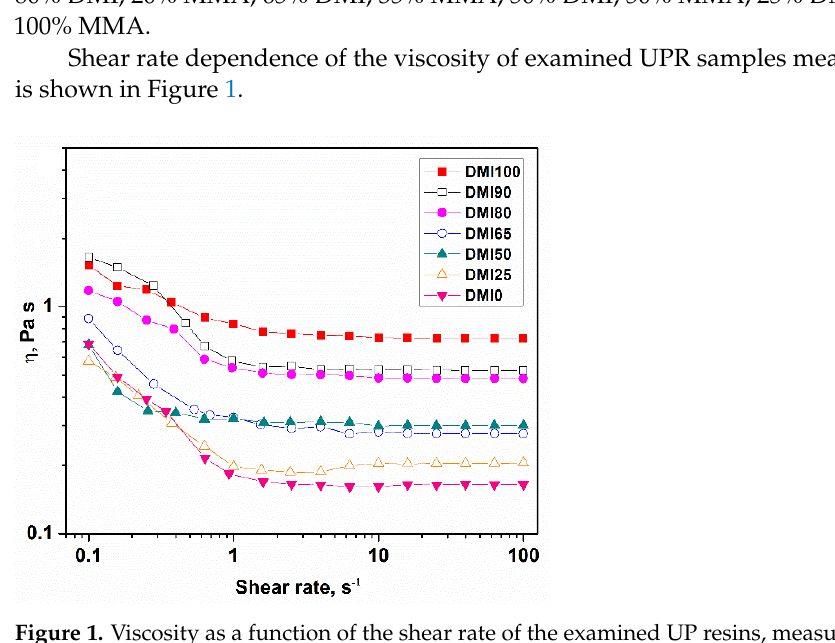
Figure 1. Viscosity as a function of the shear rate of the examined UP resins, measured at 25 ◦ C. At shear rates higher than 1 s − 1 , the viscosity of the UPRs was found to be independent of the shear rate. This behavior is characteristic of Newtonian liquids and it indicates an absence of chain entanglements. The viscosity of the UPRs decreased with an increasing amount of MMA in the reactive diluent composition. This was a result of the much lower viscosity and lower polarity of MMA compared to DMI. These UPRs represented a concentrated solution of oligomeric UP molecules in the reactive diluent. The viscosity of UPRs is not only influenced by the interactions of UP molecules with reactive diluent molecules, but also by interactions of UP molecules with other UP